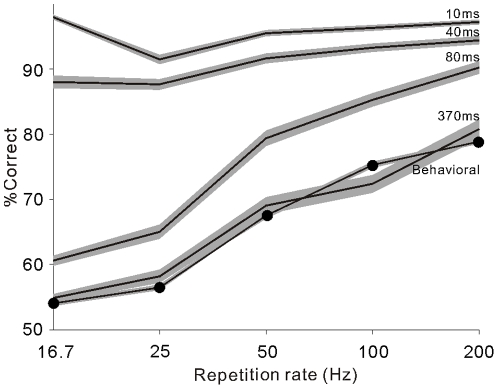
Comparison of the neurometric and psychometric functions obtained from the pooled data of 10 randomly selected units.Black line shows the mean of functions averaged across 100 repetitions of random selection. Shade area shows the 2SE. Circle marked line represents psychometric functions; others represent the neurometric functions in different time scales.